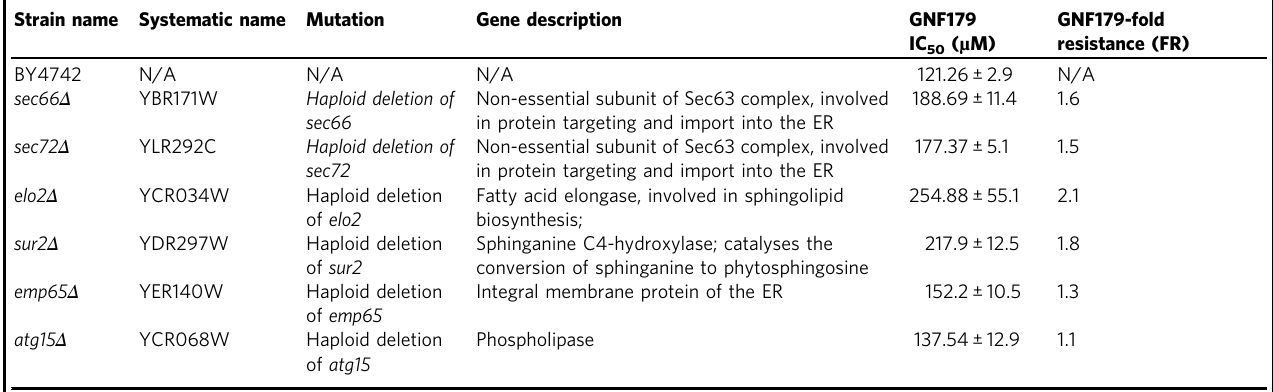
Table 3 IC 50 s (mean and S.E.M) for GNF179 in the indicated yeast haploid deletion strains. Strain name Systematic name